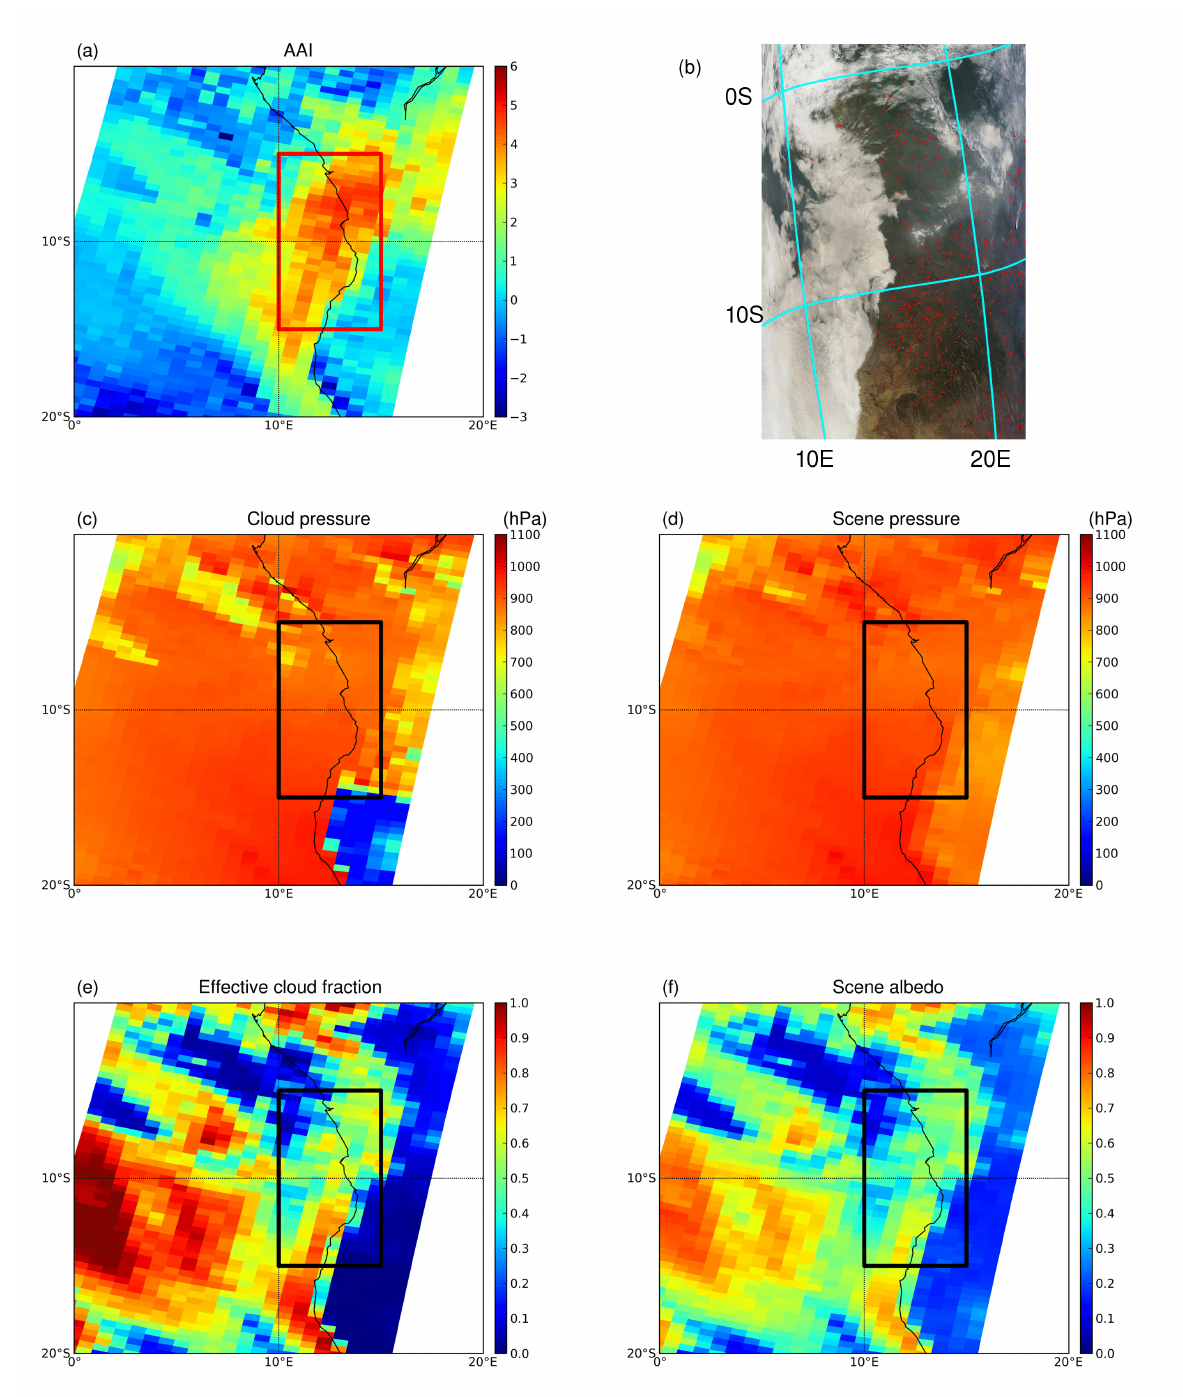
Fig. 16. (a) GOME-2 AAI image, (b) MODIS RGB image, (c) GOME-2 cloud pressure, (d) GOME-2 scene pressure, (e) GOME-2 effective cloud fraction, and (f) GOME-2 scene albedo for the biomass burning smoke event in South-West Africa on 6 August 2010. The location of the plume is indicated with a box in the GOME-2 images. The plume in the box was measured around 08:48UTC. MODIS image was measured at 09:20UTC. The red spots in MODIS images indicate